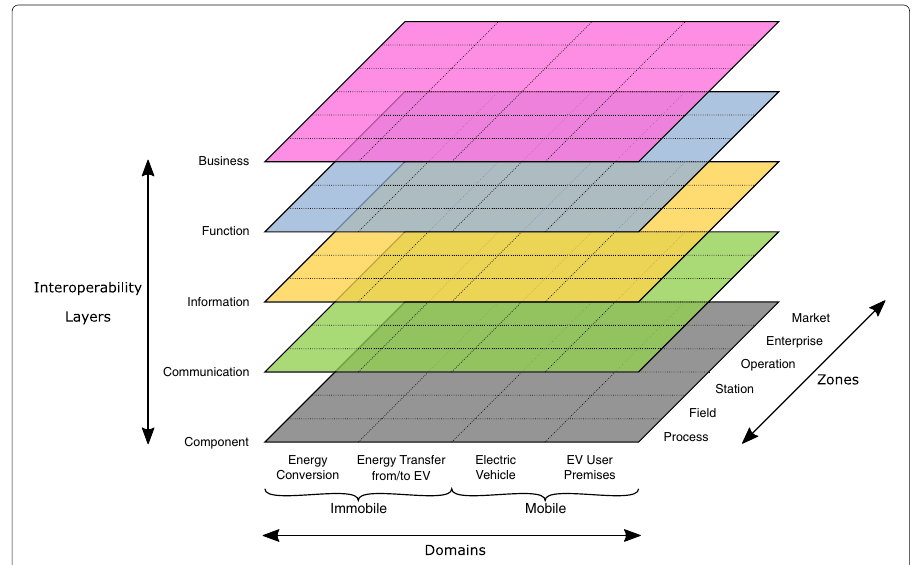
Fig. 3 Visualization of the E-Mobility Systems Architecture (EMSA)